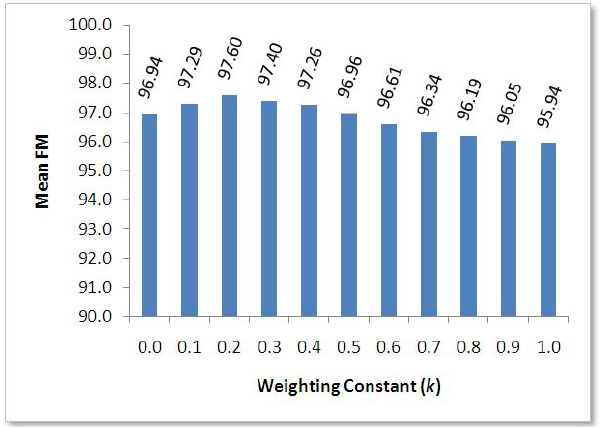
Figure 7. Mean F-measures obtained with various values of weighting constant k for 800 (cid:2) 600 resolution